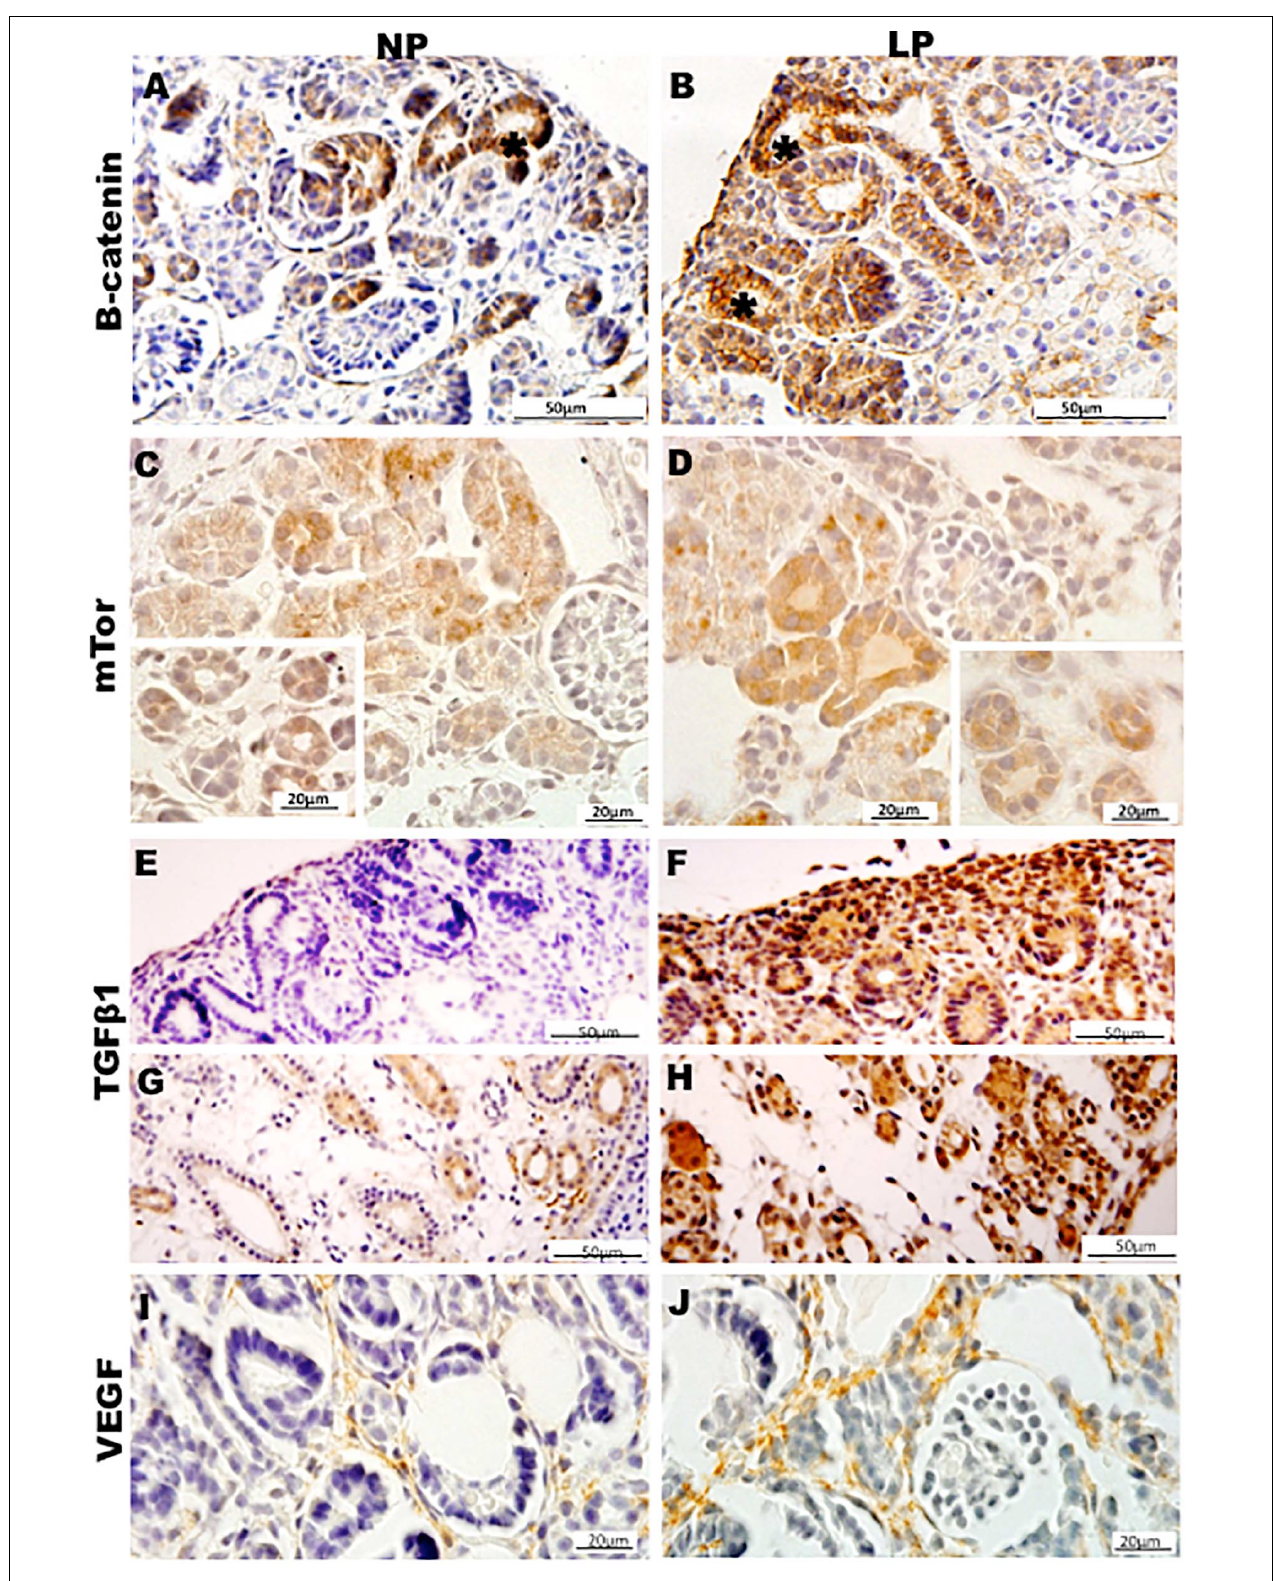
FIGURE 7 | Immunoperoxidase in kidneys of 21GD rats for (A,B) B-catenin, (C,D) mTor, (E–H) TGFb1, and (I,J) VEGF for the NP (A,C,E,G,I) and LP (B,D,F,H,J) groups. The inserts represent the medullar area. UB (*) renal vesicles.